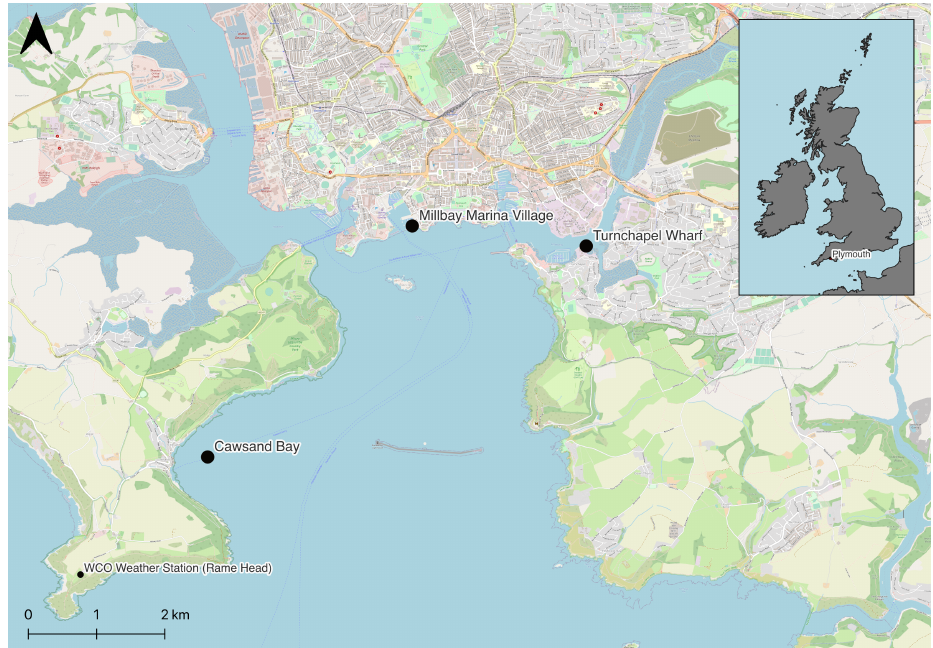
Figure 4. Map of sample sites showing the location of Turnchapel Wharf, Millbay Marina and Cawsand Bay. All sample sites are located in the southwest of England, specifically Devon and Cornwall. Background OpenStreetMap, © OpenStreetMap